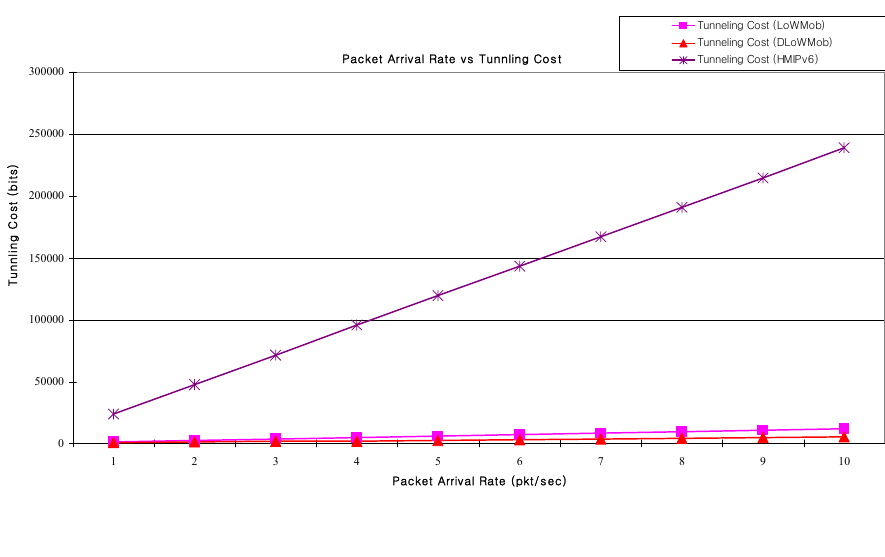
Figure 24. Tunneling cost vs. packet arrival